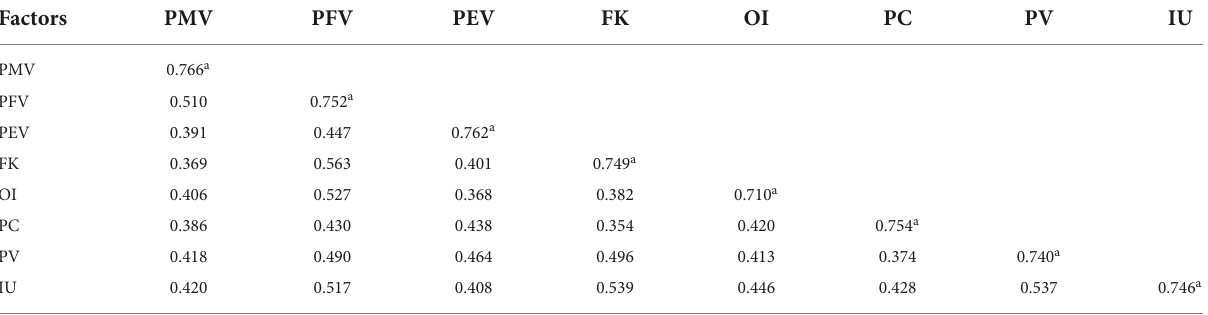
TABLE 5 Discriminant validity for the measurement model (implied correlation